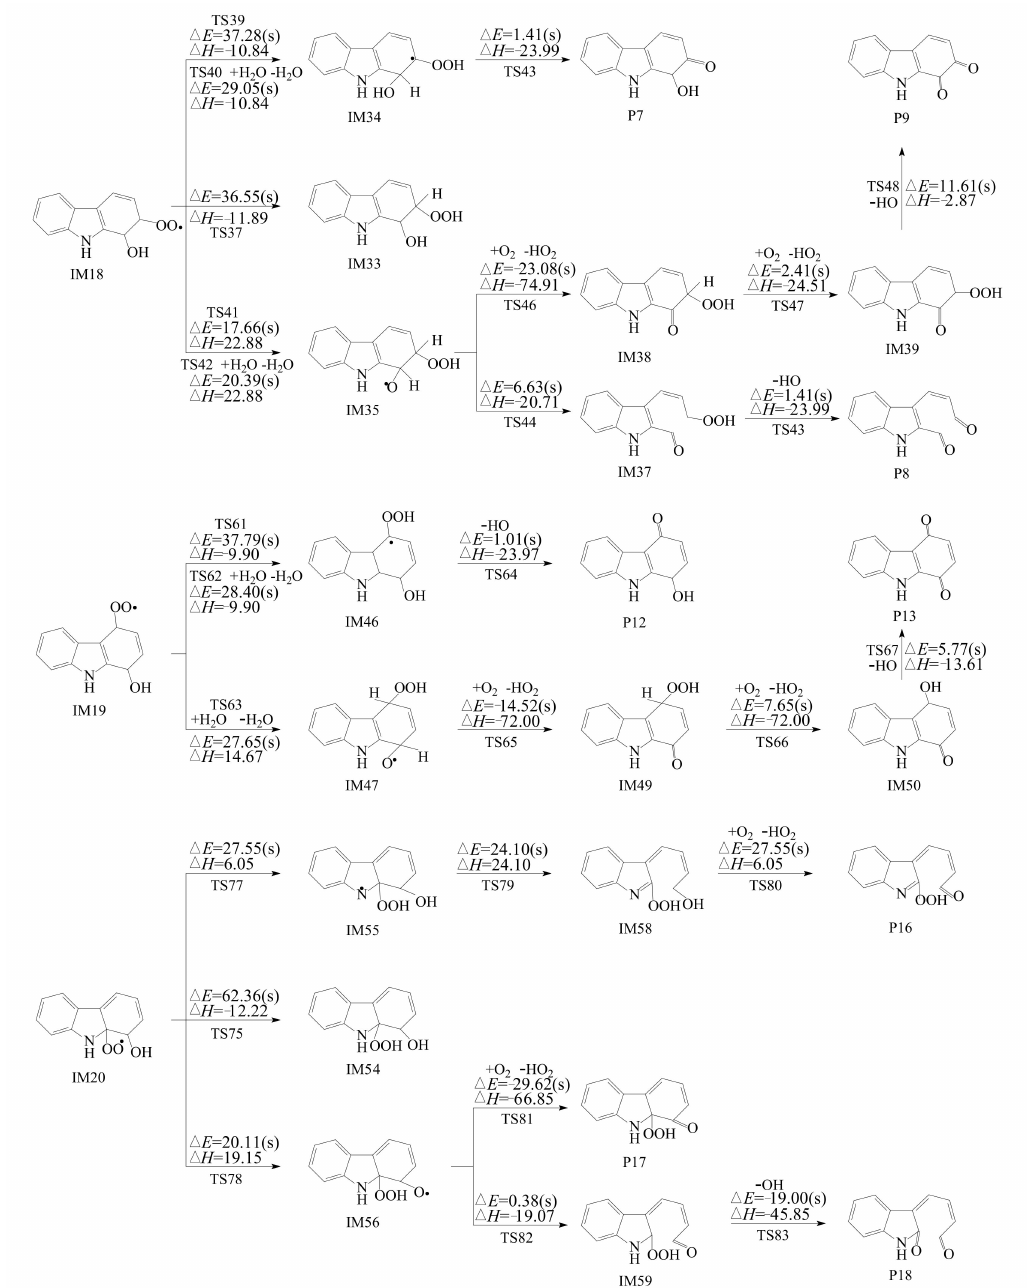
Figure 5. Intramolecular H-transfer reaction of carbazole-OH-O 2 adducts embedded with the po- tential barrier ∆ E (in kcal mol − 1 ) and reaction heat ∆ H (in kcal mol − 1 , 0 K) with and without H 2 O